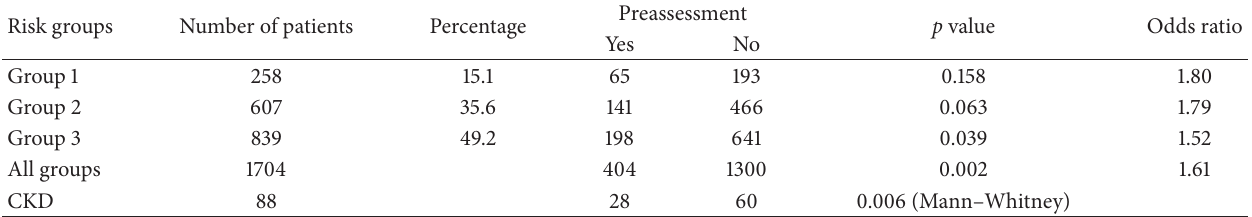
Table 2: The effect of preassessment on the quality of bowel preparation for risk groups, using binary logistic regression.